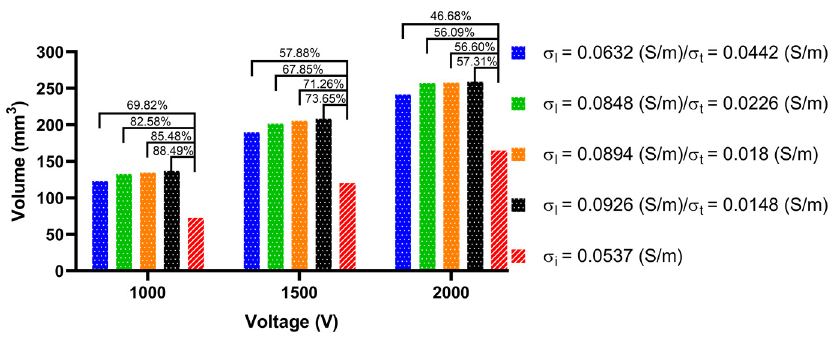
Figure 17. The statistical results of the size of the ablation volume generated by different ACs and ICs under the condition of different PFA amplitudes at ablation target 3.